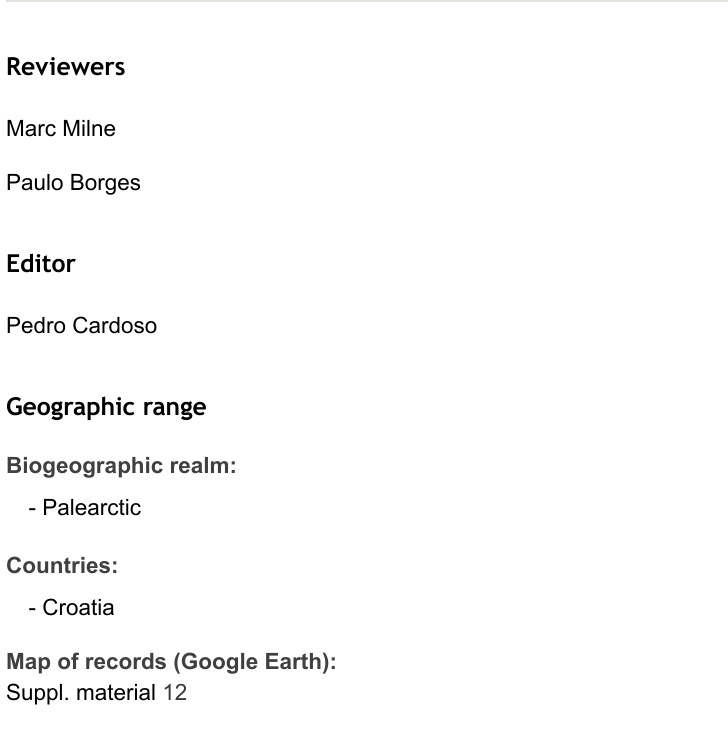
Map of records (Google